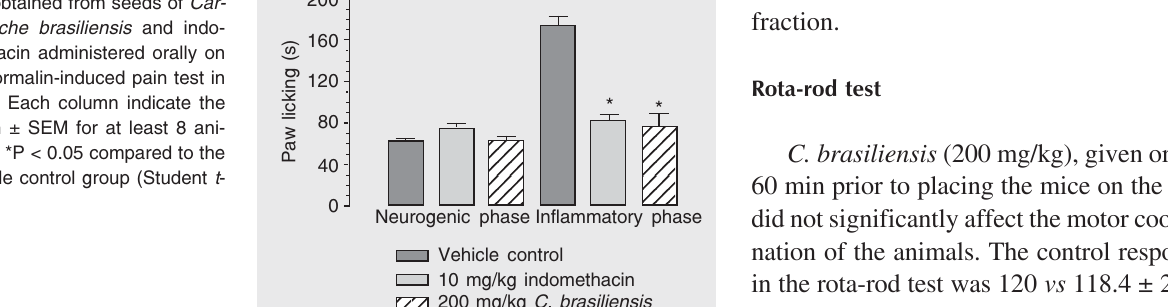
Figure 3. Effect of the acid frac- tion obtained from seeds of Car- potroche brasiliensis and indo- methacin administered orally on the formalin-induced pain test in mice. Each column indicate the mean ± SEM for at least 8 ani- mals. *P < 0.05 compared to the vehicle control group (Student t -